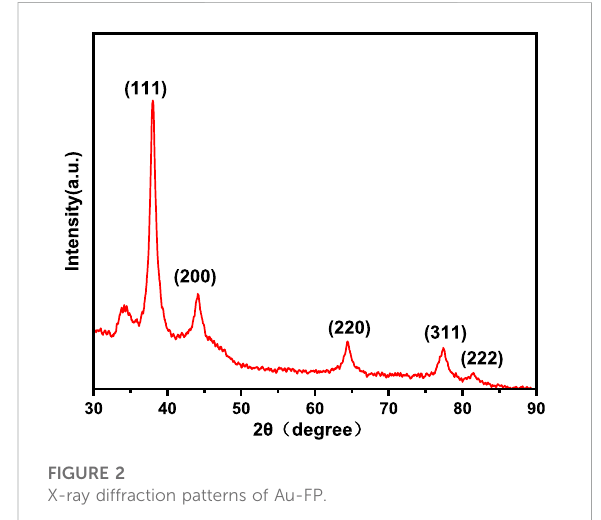
FIGURE 2 X-ray diffraction patterns of